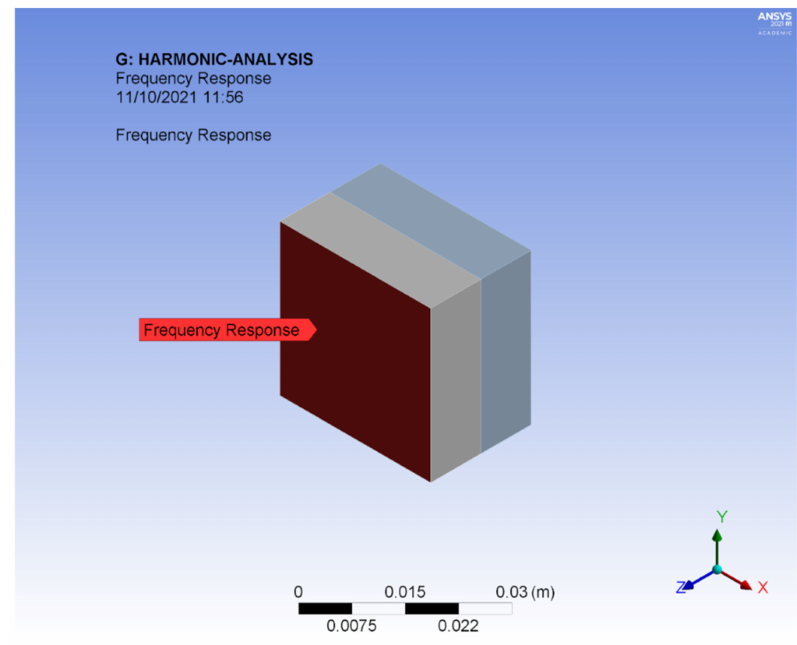
Figure 15. The face selected for frequency